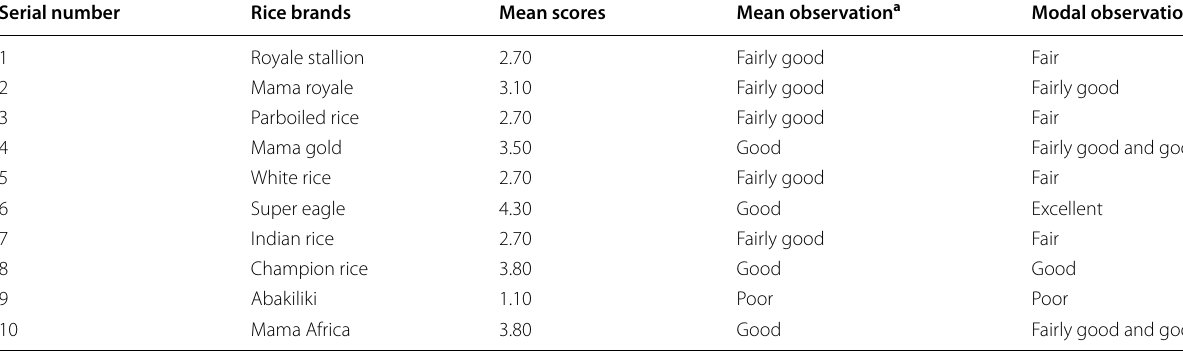
Scores 1 poor, 2 fair, 3 fairly good, 4 = = = a Representative observation was based on approximated (nearest whole number) mean scores